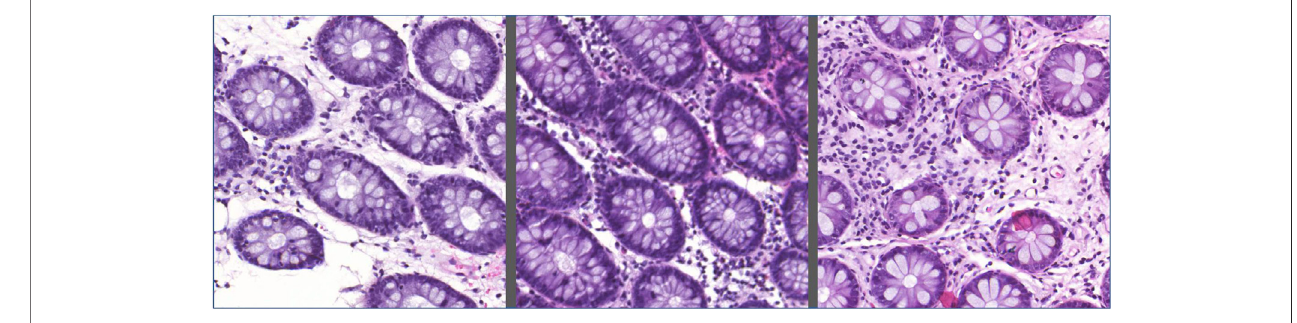
FIGURE 1 | Examples of normal colon tissues.